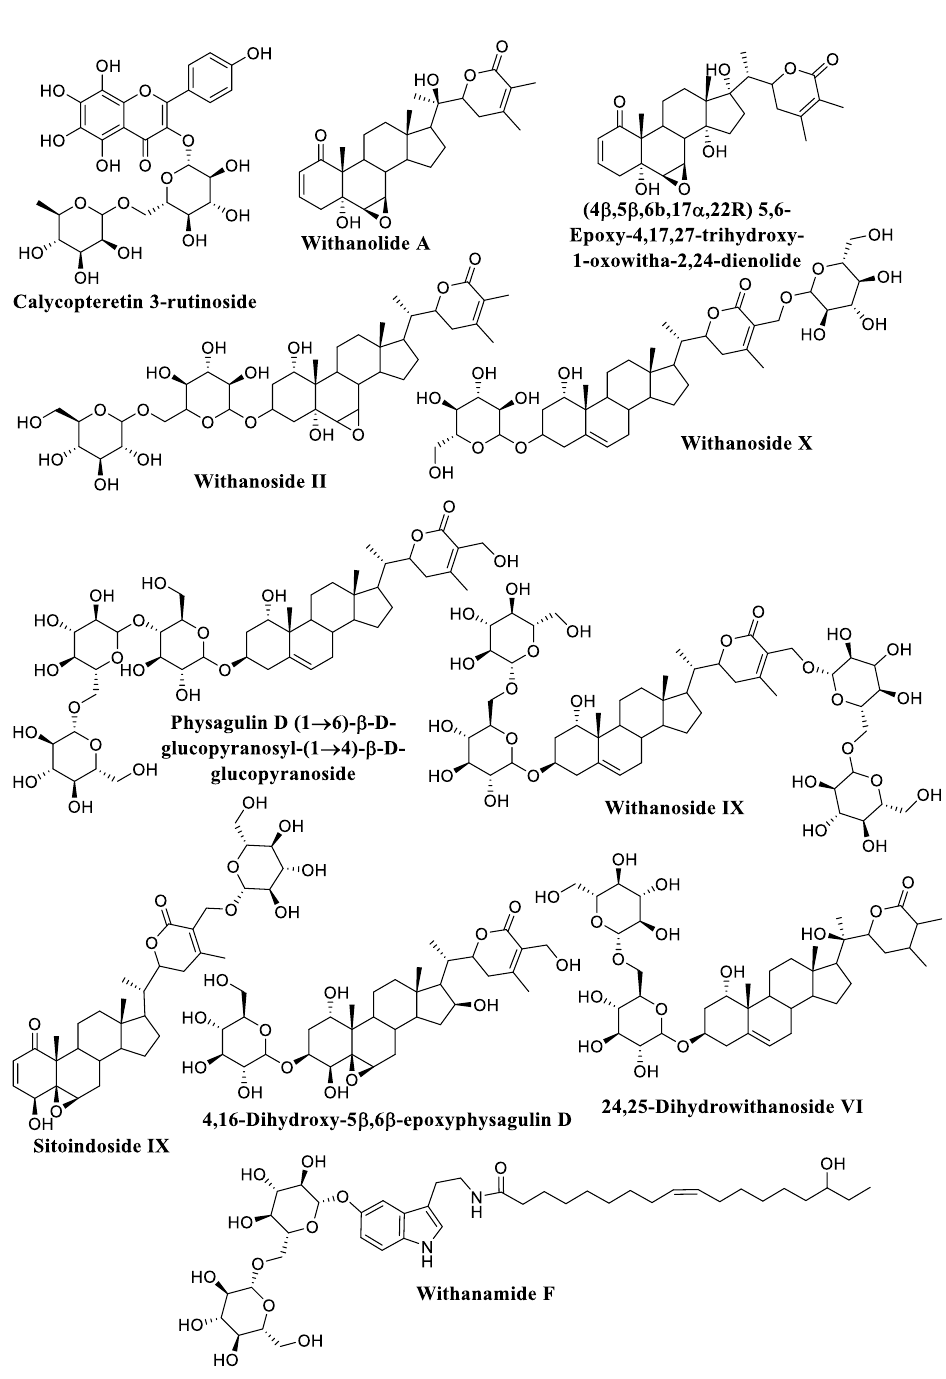
Figure 4. The structures of top-scoring compounds.